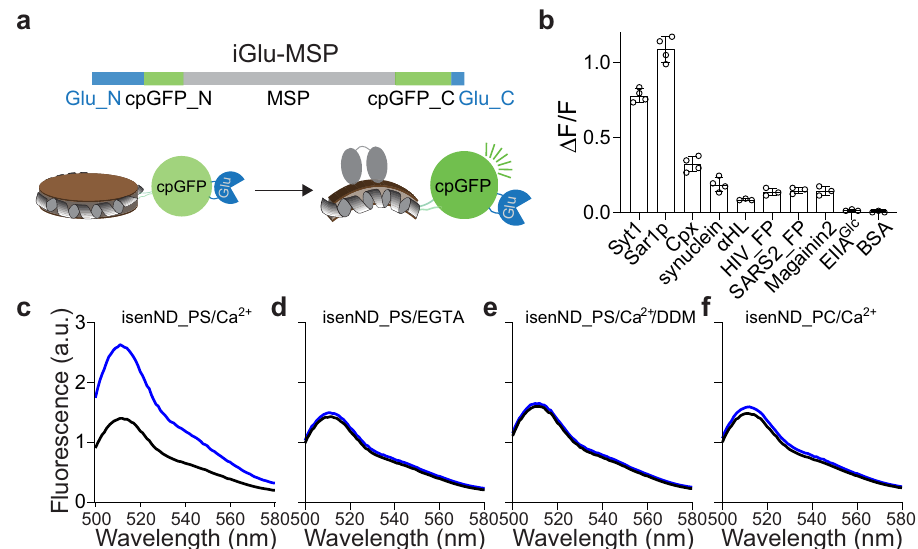
Fig. 3 Engineering isenND to sense the membrane remodeling reaction. a Illustration of iGlu-MSP. Top, construct design. Bottom, binding of syt1 bends the membrane in isenND and increases its fl uorescence. b Sensitivity of iGlu-MSP nanodiscs for different membrane remodeling proteins. iGlu-MSP nanodiscs (0.1 μ M) were incubated with the indicated protein (1 μ M) at room temperature for 10 min, followed by fl uorescence spectroscopy analyses. EIIA Glc and BSA were used as controls. Nanodiscs were prepared using 50% PC, 40% PS and 10% PE (isenND_PS) unless otherwise speci fi ed. The cytosolic domain of synaptotagmin-1 (syt1), 37 kDa; sar1p, 21 kDa; complexin-2 (cpx), 15 kDa; α -synuclein (syn), 14 kDa; α -hemolysin ( α HL), 36 kDa; HIV-1 fusion peptide (HIV_FP), 2.9 kDa; SARS-CoV-2 fusion peptide (SARS_FP), 2.5 kDa; magainin2 (Mag2), 2.5 kDa; EIIA Glc , 22 kDa; BSA, 67 kDa. c – f Representative fl uorescence spectrum of iGlu-MSP nanodiscs in the absence (black) and presence (blue) of syt1 supplemented with 0.5 mM Ca 2 + ( c ), 1 mM EGTA ( d ), or 0.5 mM Ca 2 + followed by 0.2% DDM ( e ). In the control experiment ( f ), iGlu-MSP nanodiscs contaning only PC lipids (isenND_PC) were used. Data are shown as mean ± s.d., n ≥ 3 independent